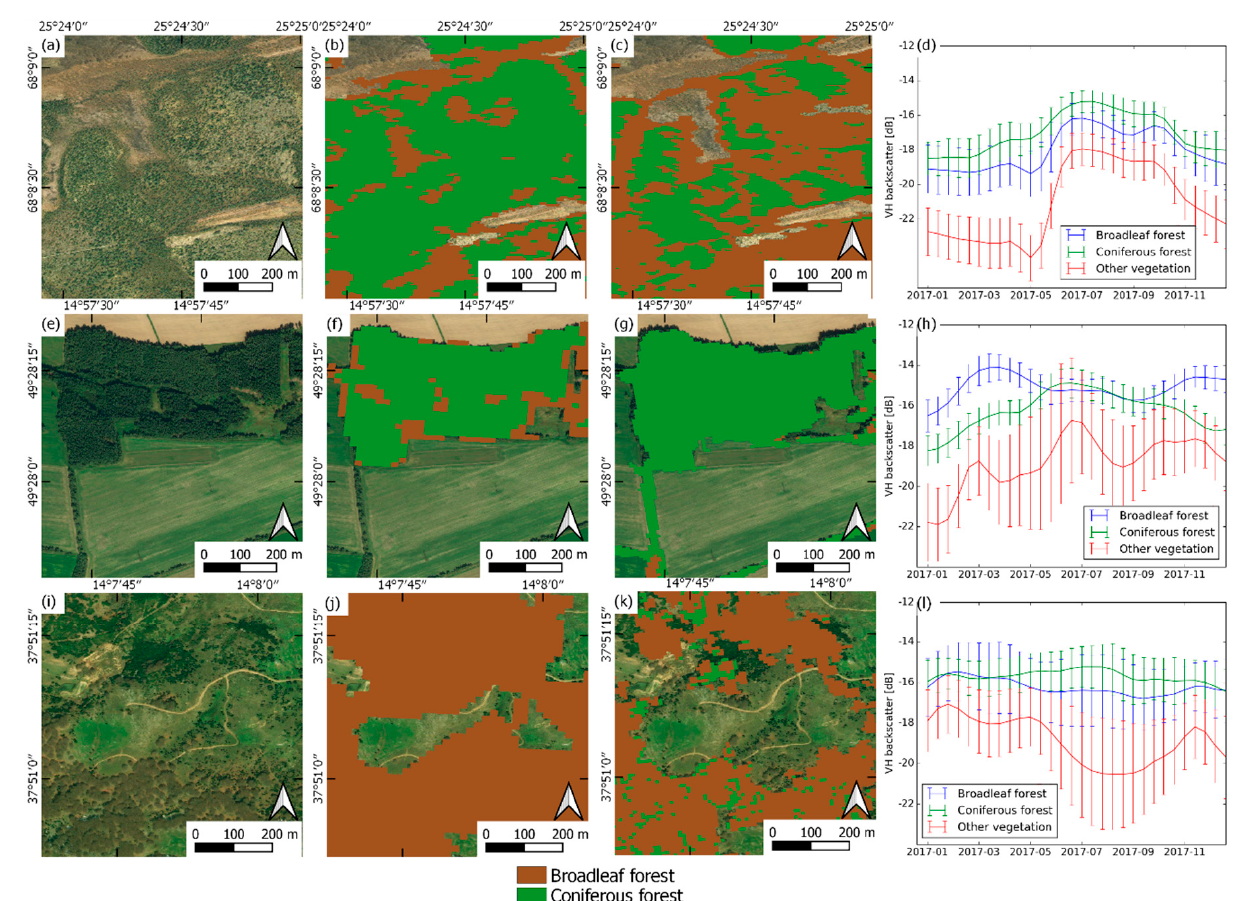
Figure 17. Examples of the forest type maps and cross-polarized backscatter temporal signatures from areas in northern Finland (boreal forest), Czech Republic (temperate forest) and Sicily (Mediterranean forest). The Bing aerial imagery is used as a base map. Temporal signatures are computed from sample of 1000 randomly selected points within a single Equi7 tile for classes coniferous forest, broadleaf forest and other vegetated areas. The solid line indicates the average backscatter value while the error bars indicate its standard deviation for each time stamp. ( a ) to ( d ) show subset in northern Finland where ( a ) shows Bing aerial image ( b ) Copernicus High Resolution Layers (HRL) forest type map, ( c ) Sentinel-1 forest type map and ( d ) temporal signature of the three vegetation classes. ( e ) to ( h ) show subset in Czech Republic where ( e ) shows Bing aerial image ( f ) Copernicus HRL forest type map, ( g ) Sentinel-1 forest type map and ( h ) temporal signature of the three vegetation classes. ( i ) to ( l ) show subset in Sicily where ( i ) shows Bing aerial image, ( j ) Copernicus HRL forest type map, ( k ) Sentinel-1 forest type map and ( l ) temporal signature of the three vegetation classes.